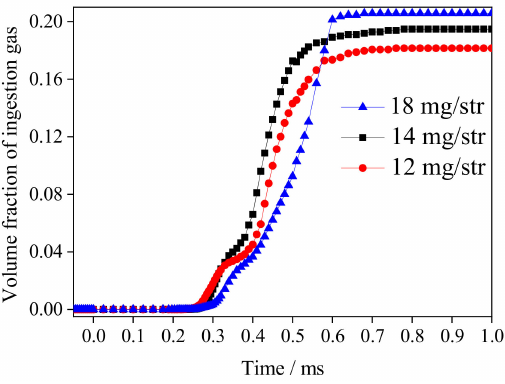
Figure 11. Effect of different mass fluxes on gas